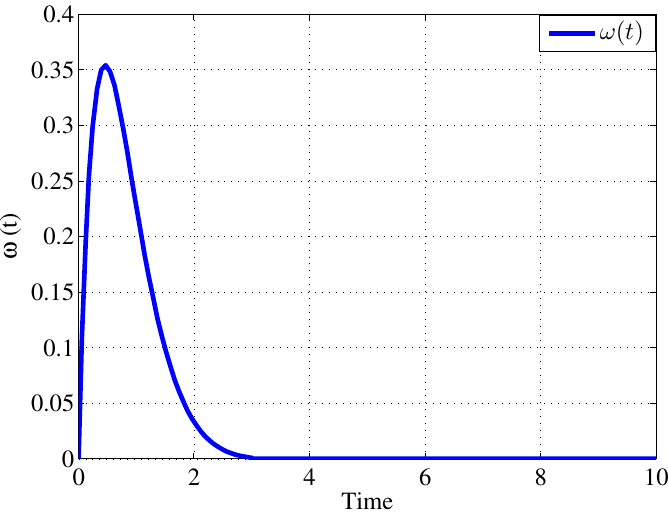
Figure 2. Disturbance ω ( t ) .